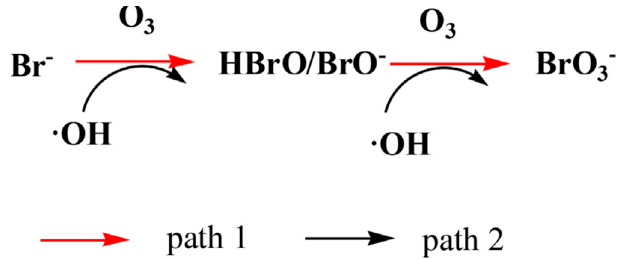
Figure 2. Formation route for bromate.